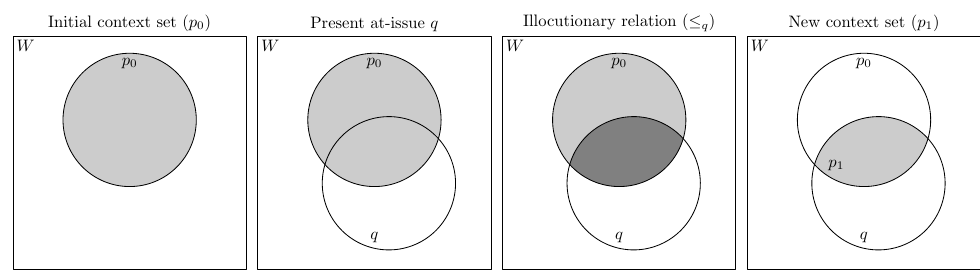
Updates for ( 19 ): simple English sentence (no not-at-issue